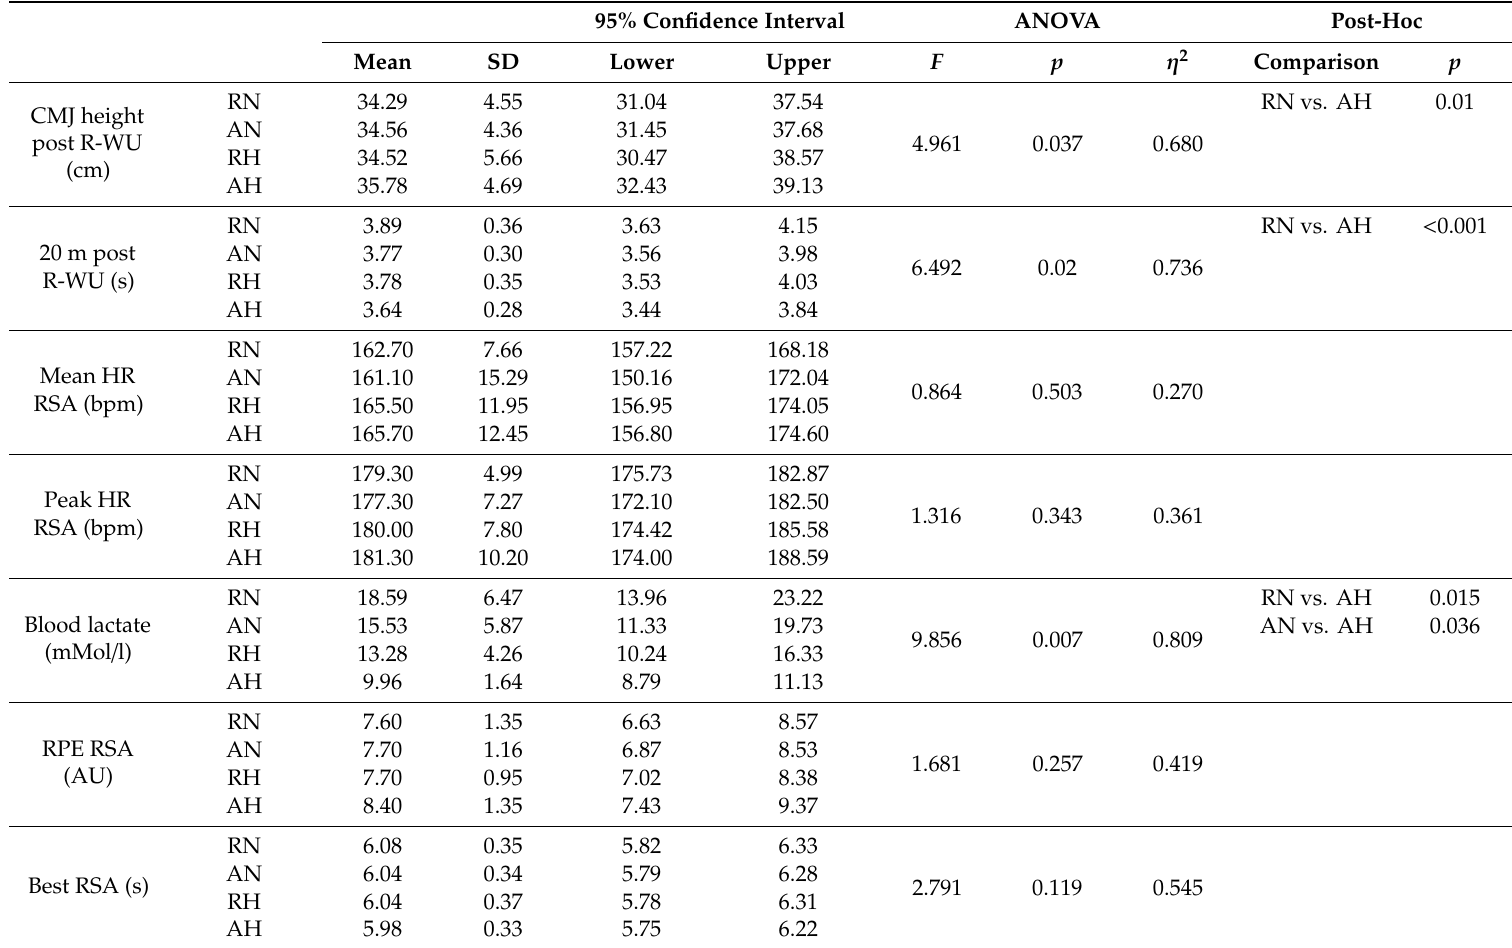
Table 3. Results after the 15 min period after warm-up in the four re-warm-up strategies applied. 95% Confidence Interval ANOVA